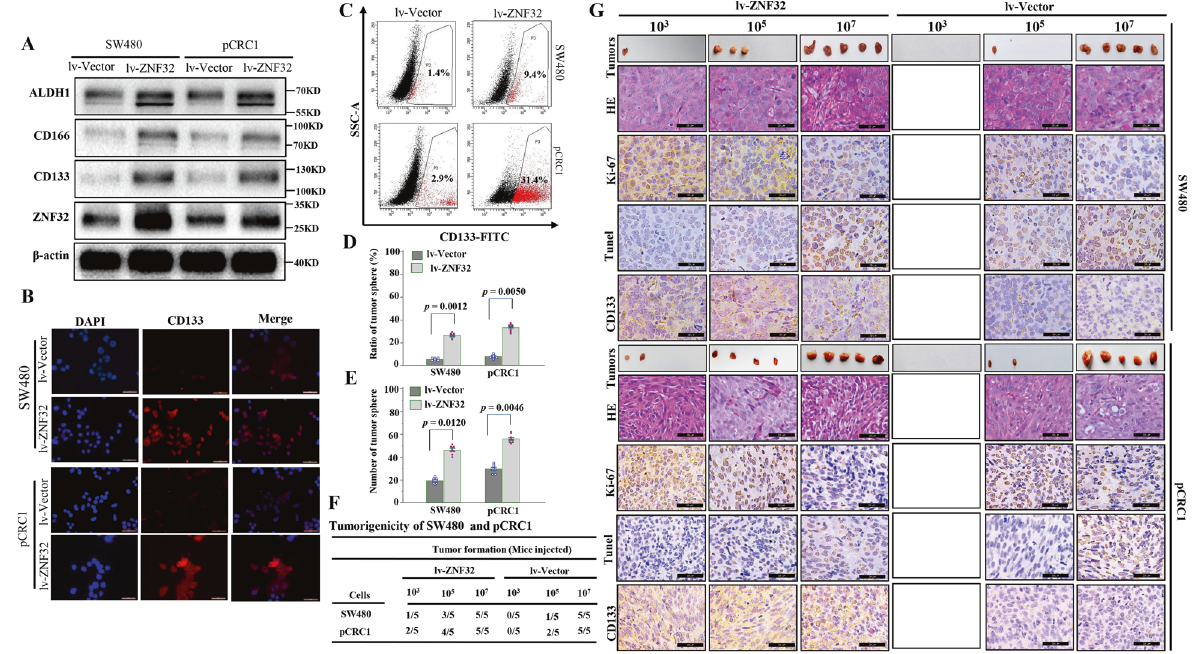
Fig. 2 Overexpression of ZNF32 in CRC cells increased the self-renewal capacity. ( A ) Western blot analysis of ZNF32, CD133, CD166 and ALDH1 between ZNF32-overexpressing (lv-ZNF32) and control (lv-Vector) SW480 and pCRC1 cells. The image is one represent of